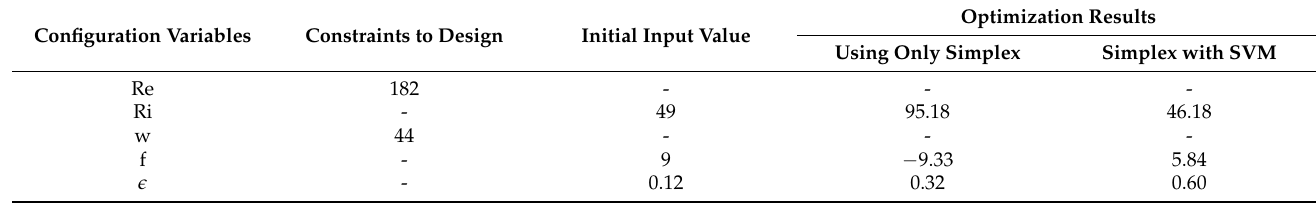
Table 7. Grain design